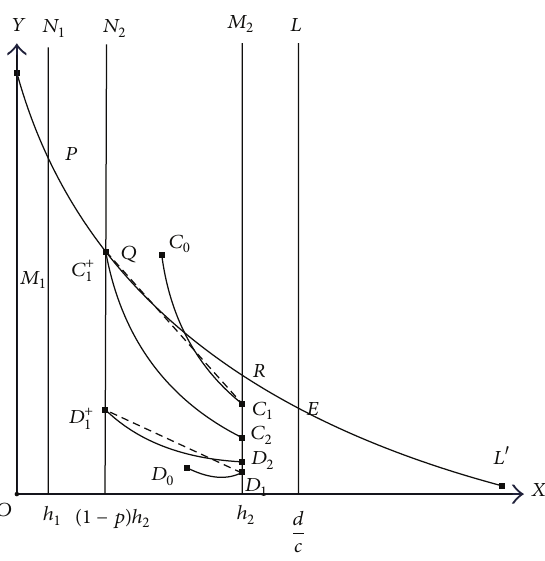
Figure 9: The orbit starting from the point 𝑄 (Case 3 in Section 4.1.2).